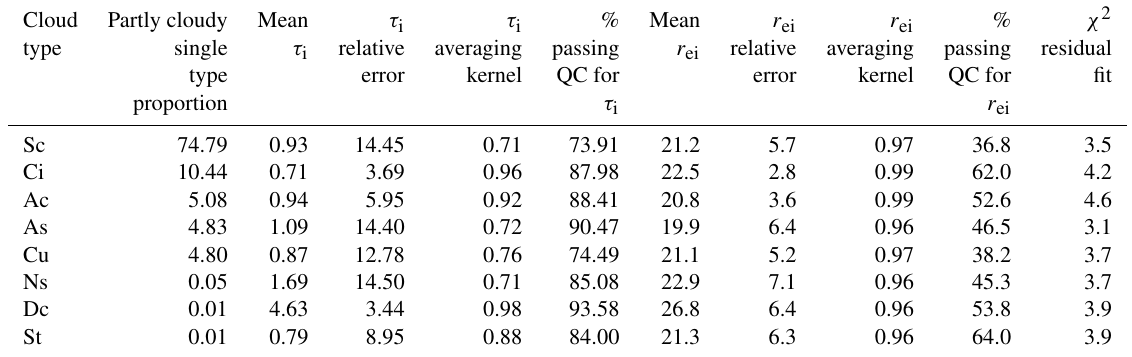
Dc 0.01 St 0.01